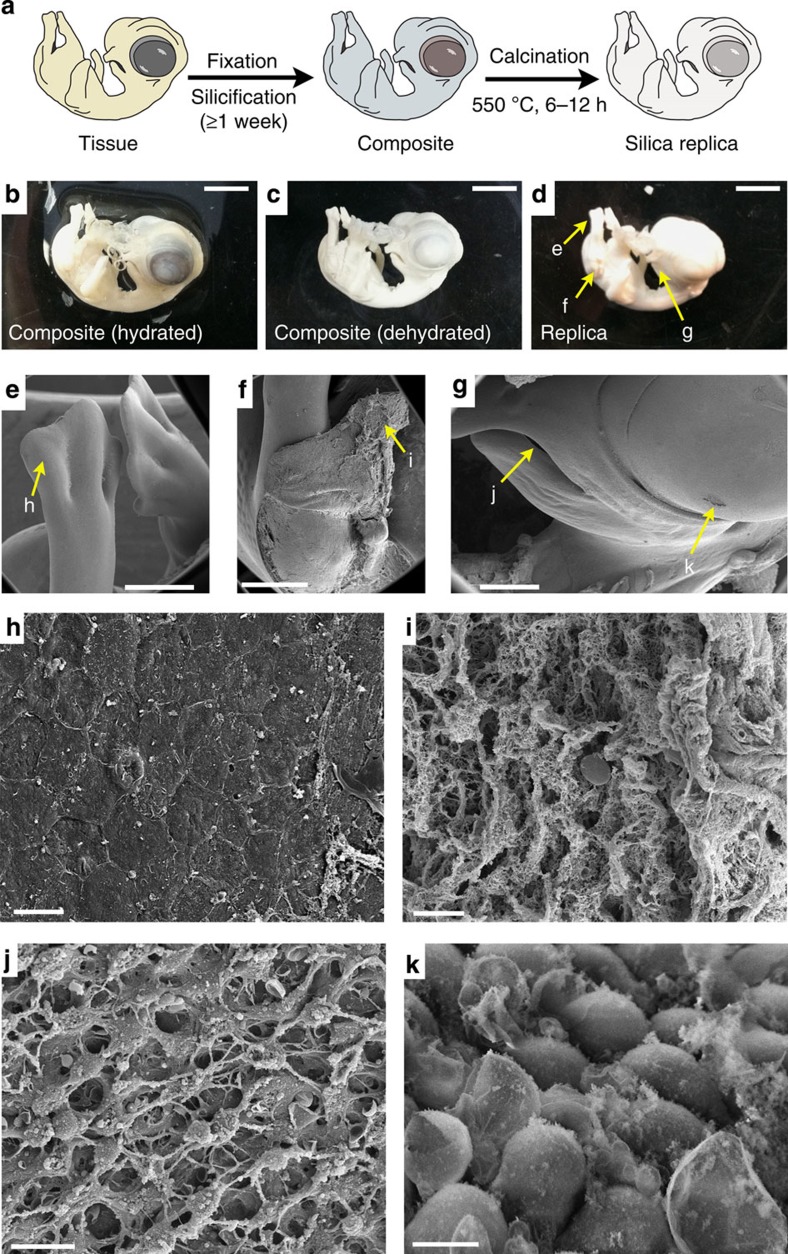
Silica bioreplication of a chicken embryo.(a) Schematic showing the silica bioreplication (SBR) process on an intact chicken embryo. The corresponding SBR composite of a 9-day-old chicken embryo (before (b) and after (c) dehydration) and (d) after calcination at 500 °C to produce a silica replica (scale bar (b–d), 5 mm). Embryo shows minimal shrinkage or shape change following dehydration (c) and calcination (d). (e–g) (Scale bars, 1 mm) Positions of the magnified images showing (h, scale bar, 10 μm) surface dermal tissue, (i, scale bar, 20 μm) subsurface cellular connective tissue, (j, scale bar, 10 μm) subsurface cells of the ocular membrane, (k, scale bar, 5 μm) surface cells of the developing tongue. SEM images were acquired following sputter coating of Au/Pd to a thickness of 10 nm.